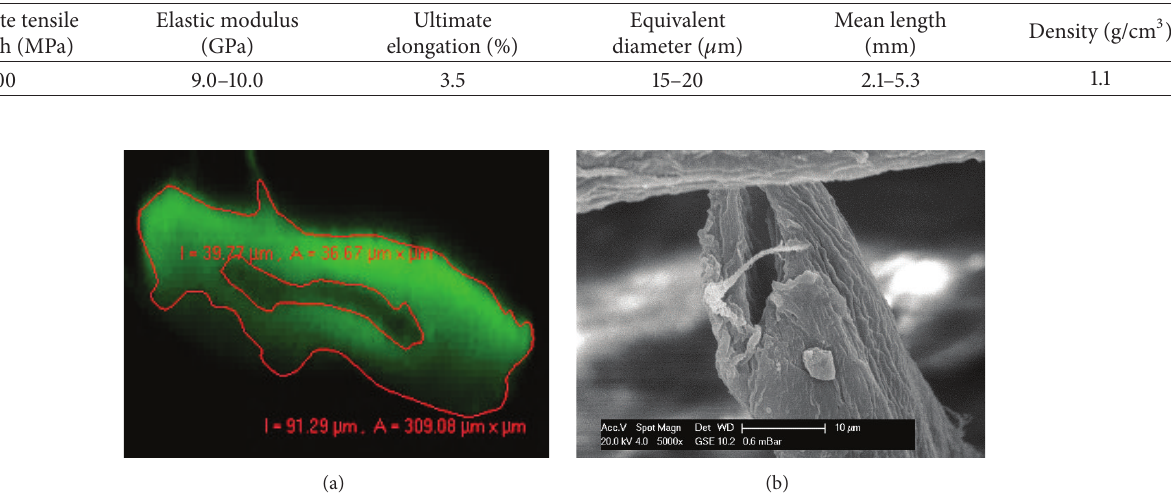
Table 1: Physical and mechanical properties of cellulose fiber.